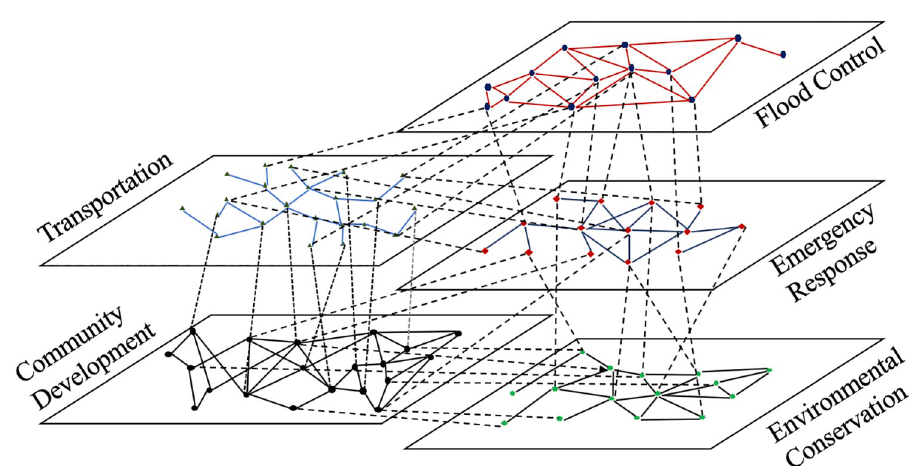
Fig 3. A multilayer network of five interdependent infrastructure